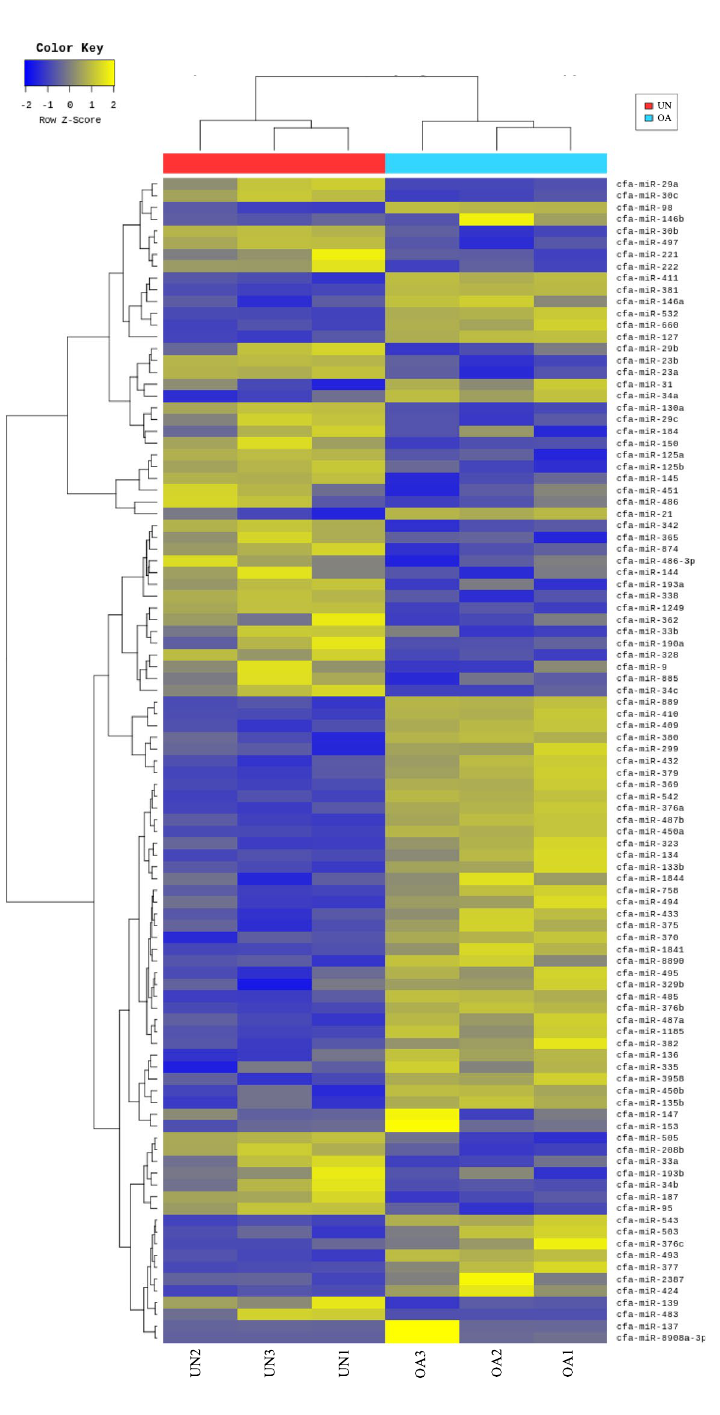
Figure 5. Heat map of the one-way hierarchical clustering using Z-score for normalized value. ( A ) Heatmap shows the result of hierarchical clustering analysis of mature miRNAs and samples by expression level (normalized value) from a significant list. ( B ) miRNAs with low sample-to-sample variability in each group. UN, unaffected group; OA, osteoarthritis